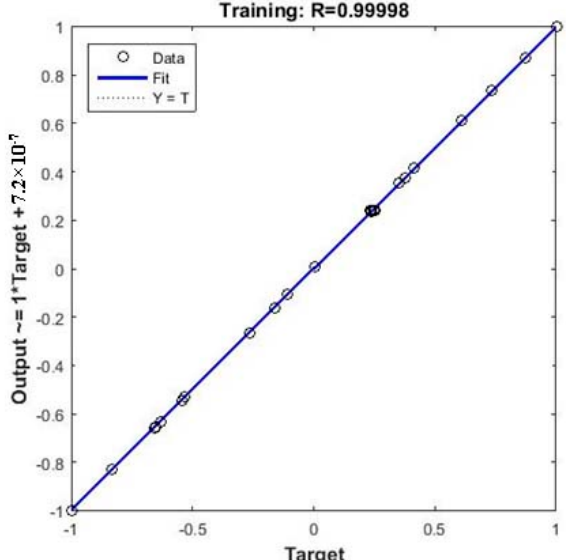
Figure 4. Correlations between data predicted by BP-ANN model and experimental data.